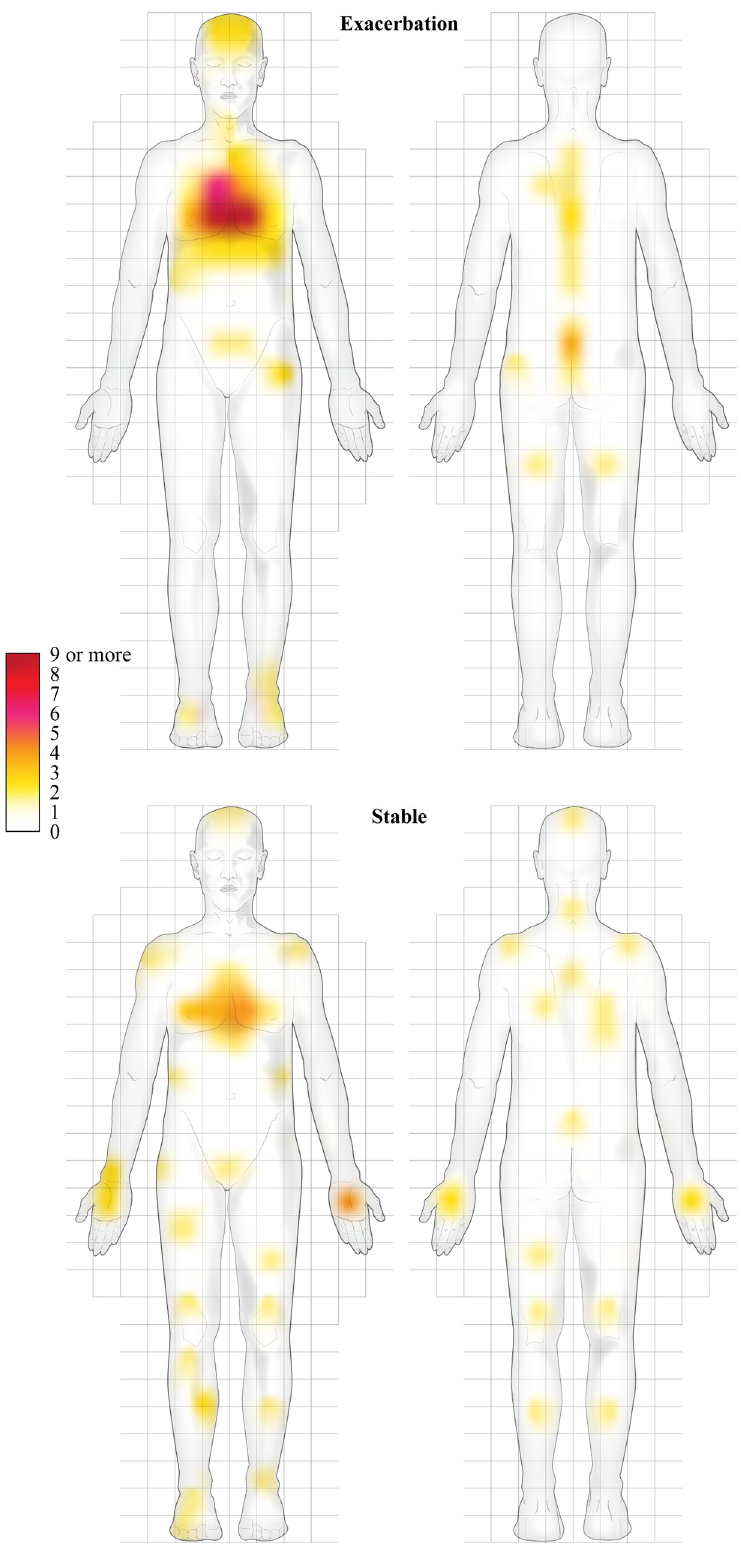
Fig 3. Location of pain during the exacerbation and stable phases. The grid was used to count each mark made by a patient. Patients could mark one or more areas. https://doi.org/10.1371/journal.pone.0217370.g003 PLOS ONE | https://doi.org/10.1371/journal.pone.0217370 May 24,